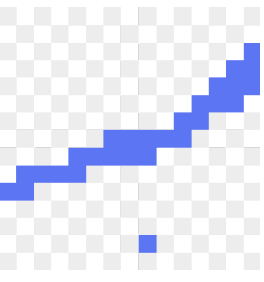
Figure 16. Grid 15 × 15 (manual best case).